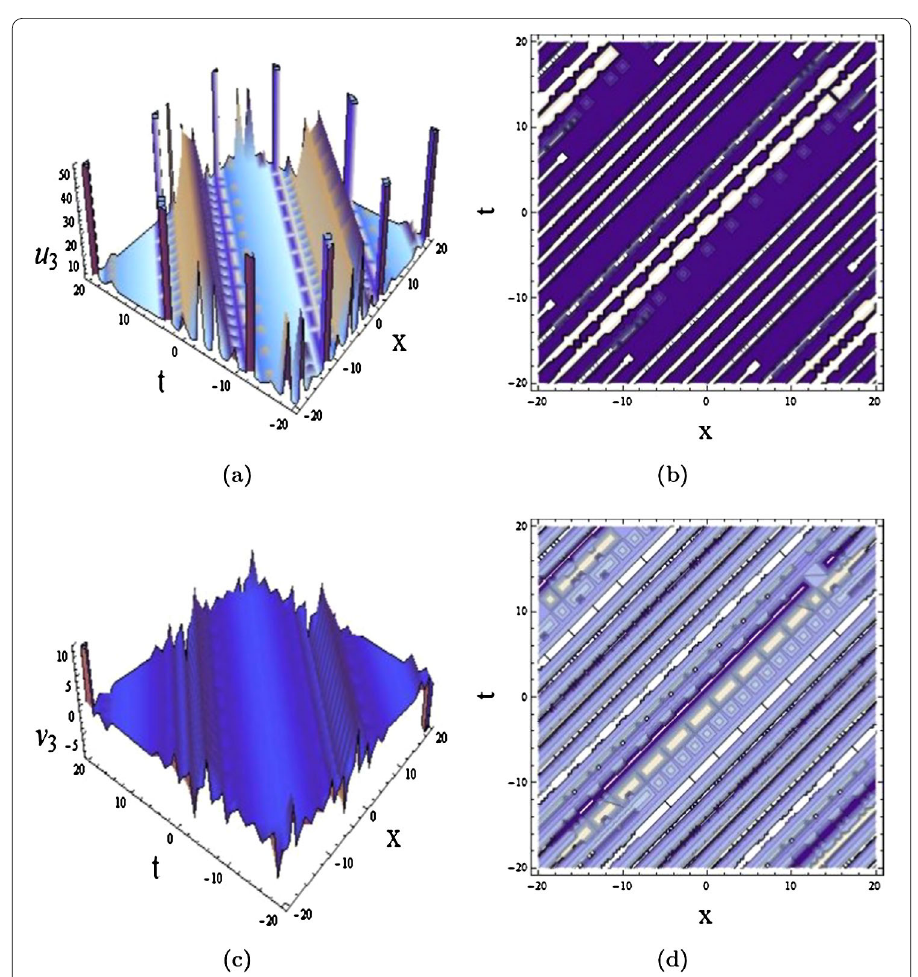
Figure 2 Plot of explicit solution (36) with a = b = k = q = 1. (a) Perspective view of the solution u 2 ( x , t ). (b) Overhead view of the solution u 2 ( x , t ). (c) Perspective view of the solution v 2 ( x , t ). (d) Overhead view of the solution v 2 ( x , t